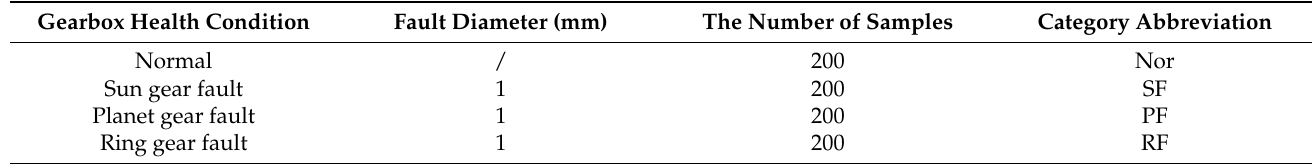
Table 3. Gearbox dataset settings under three working loads (50 Nm, 150 Nm, and 250 Nm).